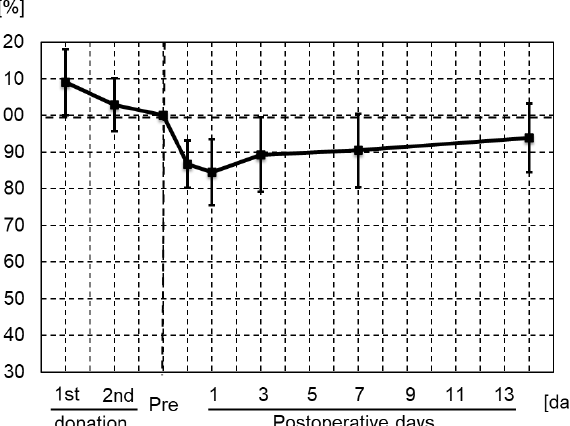
Figure 2. Percentage of the Hb concentration the day before the operation for all patients. The percentage of the preoperative Hb concentration was lowest on day 1 (84.5%), and recovered to 93.9% on day 14.